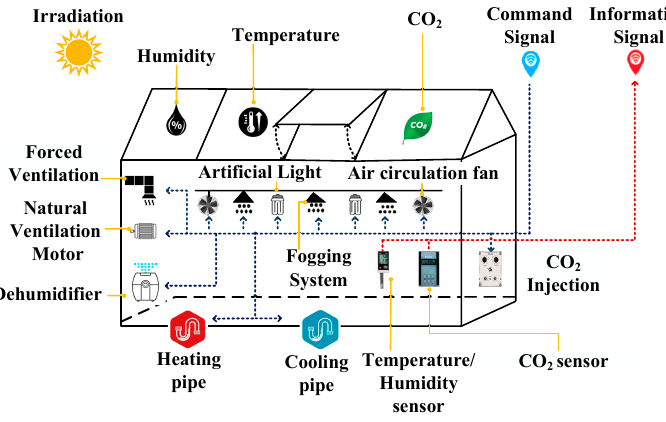
Figure 2. Greenhouse configuration.